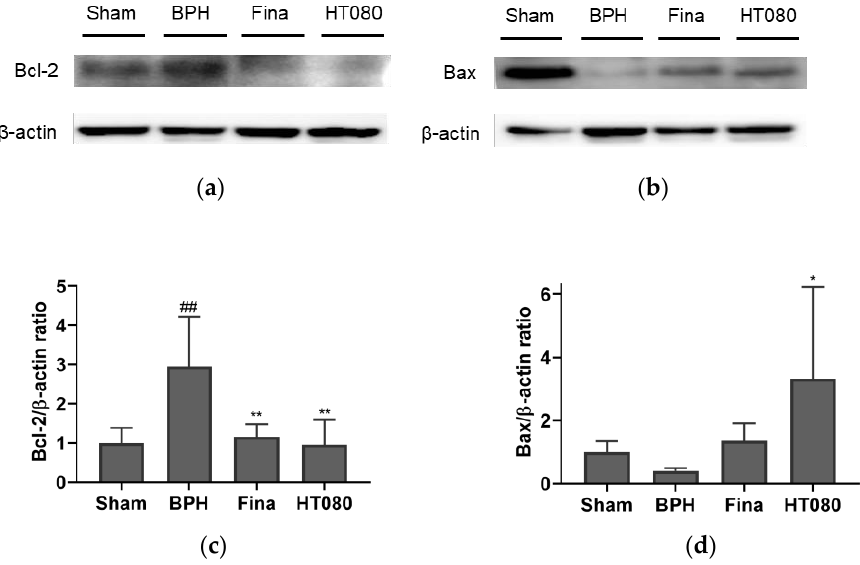
Figure 7. Effects of HT080 on the expression of Bax and Bcl-2 proteins via western blot: Representative western blot analysis of Bax ( a ) and Bcl-2 ( b ), relative densitometry evolution of Bcl-2 ( c ), and relative densitometry evolution of Bax ( d ). Statistical significance: ## p < 0.01 (compared to sham group using Dunnett’s test); * p < 0.05 and ** p < 0.01 (compared to BPH group using Dunnett’s test). Values are expressed as the mean ± S.D. Fina, finasteride.